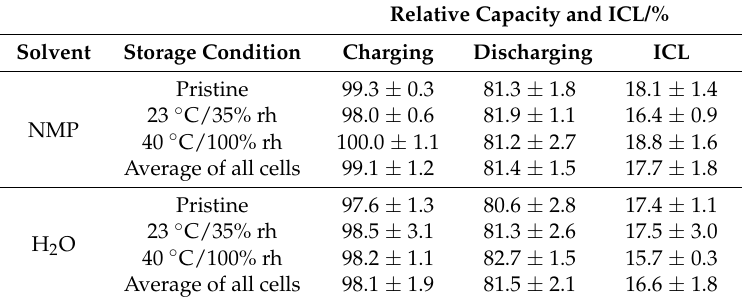
Table 4. Relative charge and discharge capacities and irreversible capacity loss (ICL) observed during the full-cell forming step. Table shows all combinations of sample ageing conditions and subsequently used solvent for slurry preparation. The highest observed charge capacity (147.2 mAh · g − 1 ) was set to 100% and all other charge and discharge capacities set in relative relation to this value. ICL was calculated within each parameter set. Errors are estimated from a minimum of three full-cells for each parameter set.